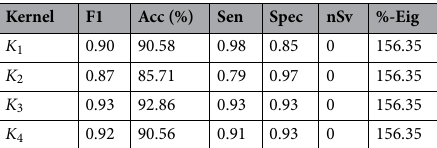
Table 7. Best results obtained from classification with single kernels applied to the validation (peptide)